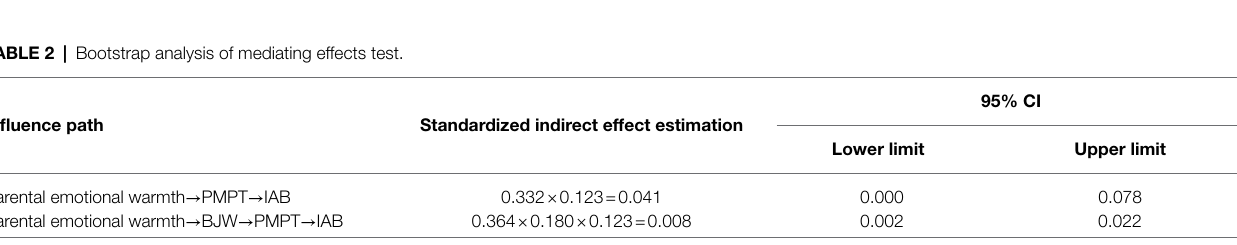
TABLE 2 | Bootstrap analysis of mediating effects